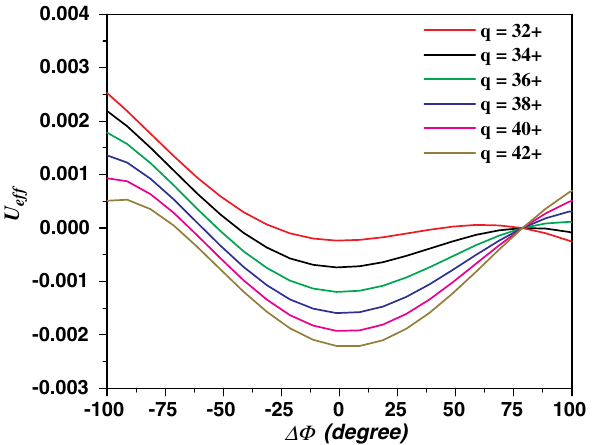
FIG. 3. Alternating phase variation and energy profile along the APF